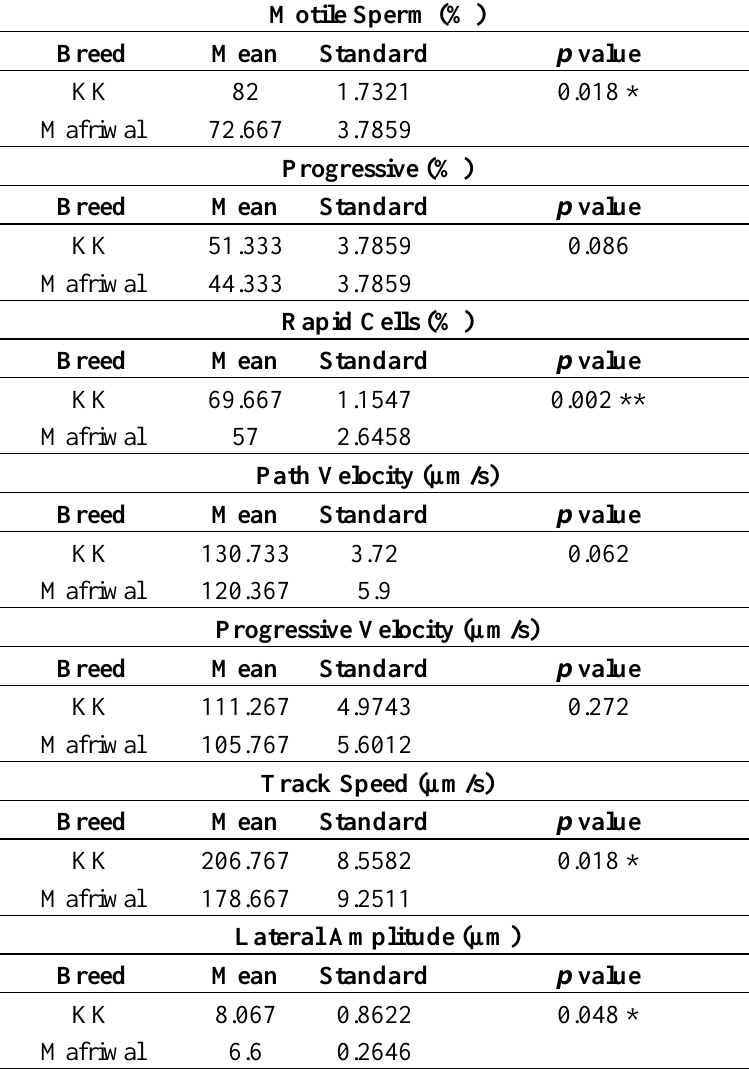
Table 3. Sperm motility analysis by